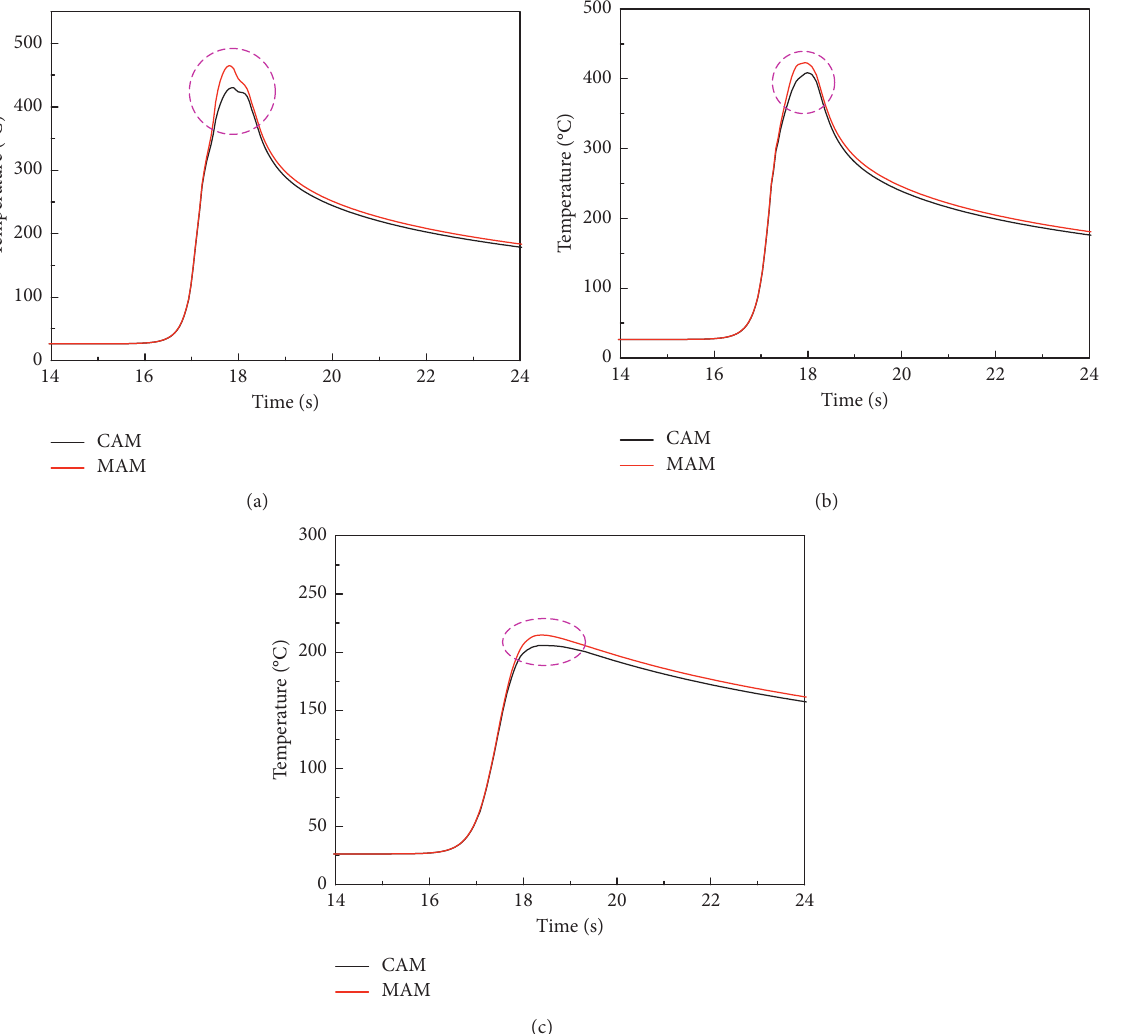
Figure 19: The predicted thermal cycles of different zones in the traverse stage. (a) NZ; (b) TMAZ; (c)